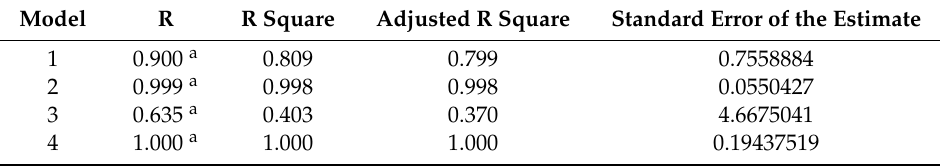
Table 1. Model summary.